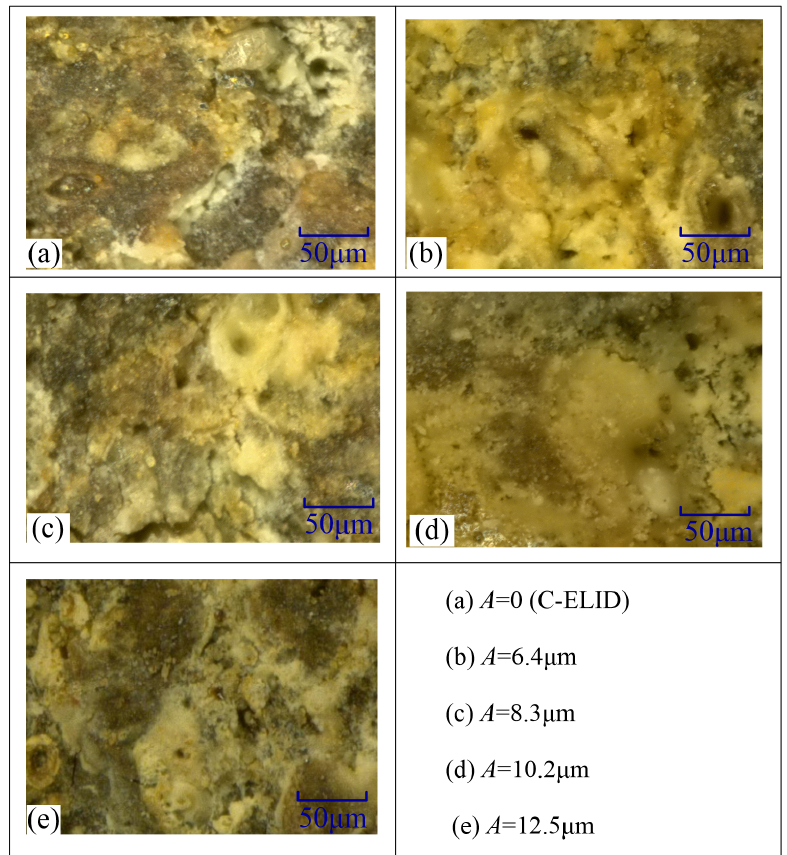
Figure 9. Effect of ultrasonic cavitation on the grinding wheel surface.